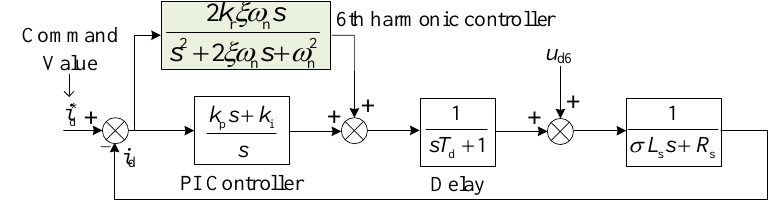
where ω n is the resonant frequency, and it is also set as the 6th harmonic angular frequency, ζ is the damping ratio, and k r is the coefficient of G R ( s ). Ignoring the influence of the cross-coupling in d-q axis, the control diagram of the current loop d -axis is shown in Figure 9. Figure 9.